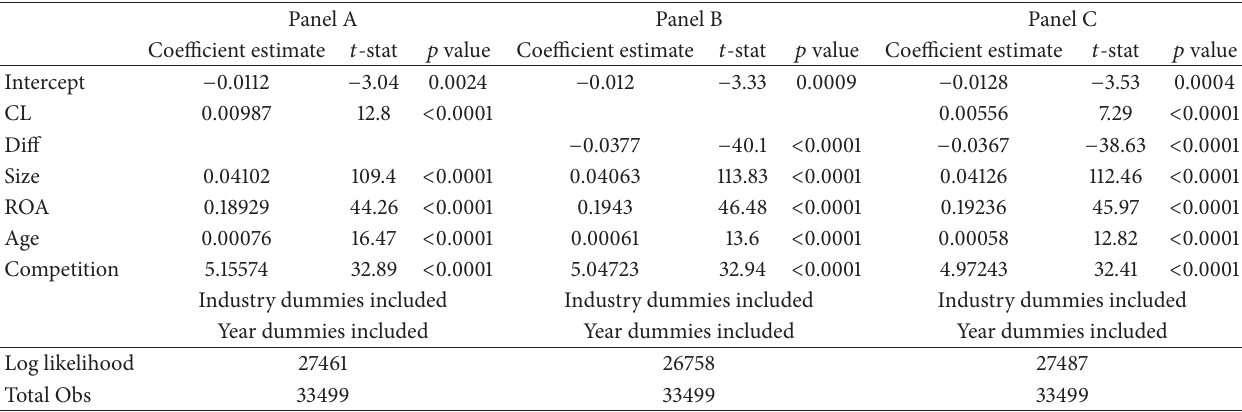
Table 4: Strategic positioning and production efficiency ( 𝑁 = 33,499). Tobit regressions in the 2nd stage of 2-stage DEA analysis. Dependent variable: production